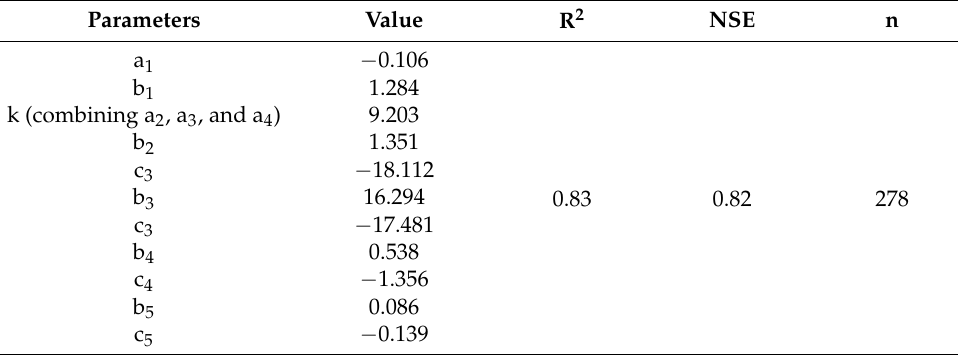
Table 4. Parameter values from the optimization of the modified Jarvis—Stewart